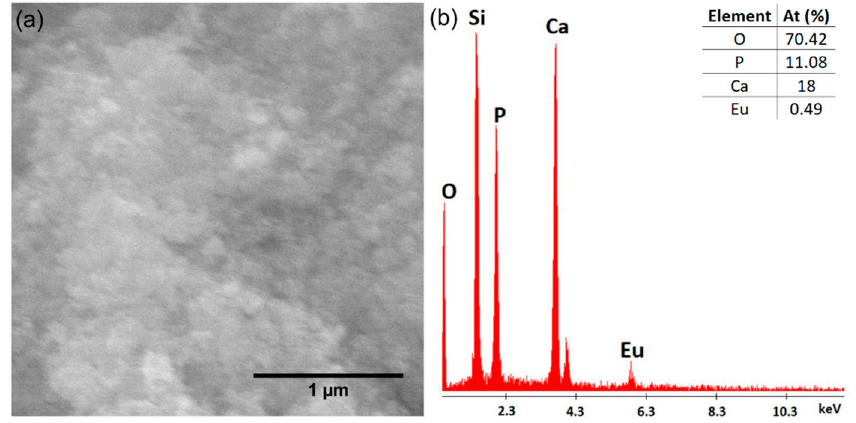
Figure 6. SEM micrographs ( a ) and EDS spectra ( b ) of europium doped hydroxyapatite thin films.